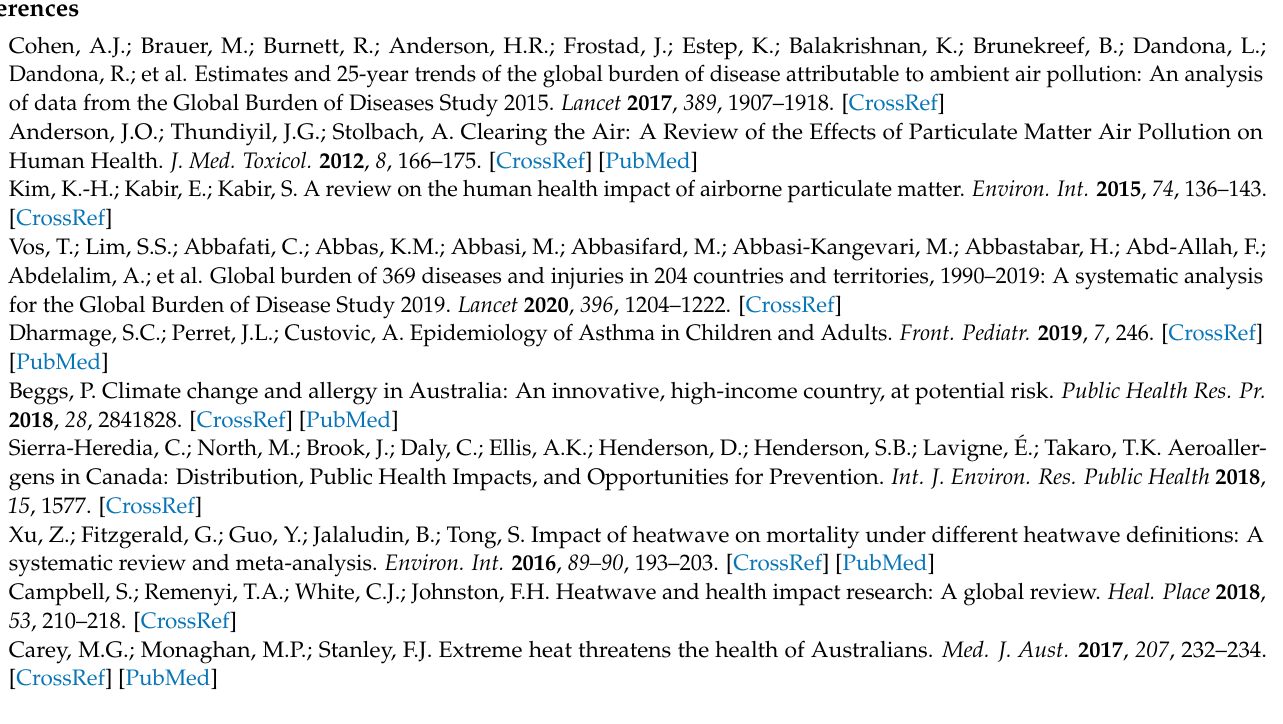
Figure S2: Schematic representation of the AirRater platform. Figure S3: DPSEEA framework. Ta- ble S1: Pre-interview questionnaire. Table S2: Interview schedule for semi-structured interviews with AirRater users. Table S3: Characterization of AirRater using the BCW framework. Table S4: Defini- tions for model of behavior, intervention functions and policy categories for the BCW framework. Table S5: Summary of participant characteristics stratified by